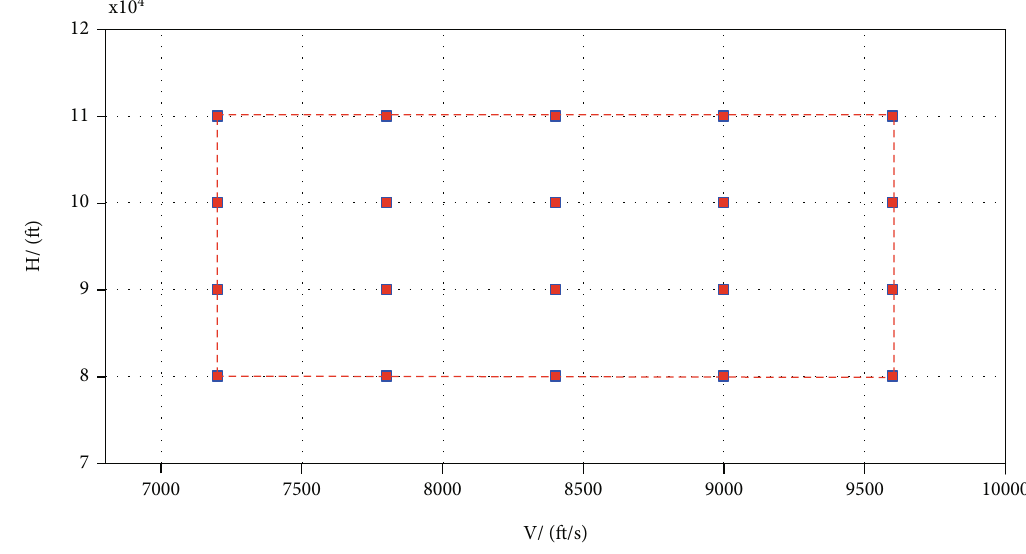
Figure 1: Scheduling parameter mesh